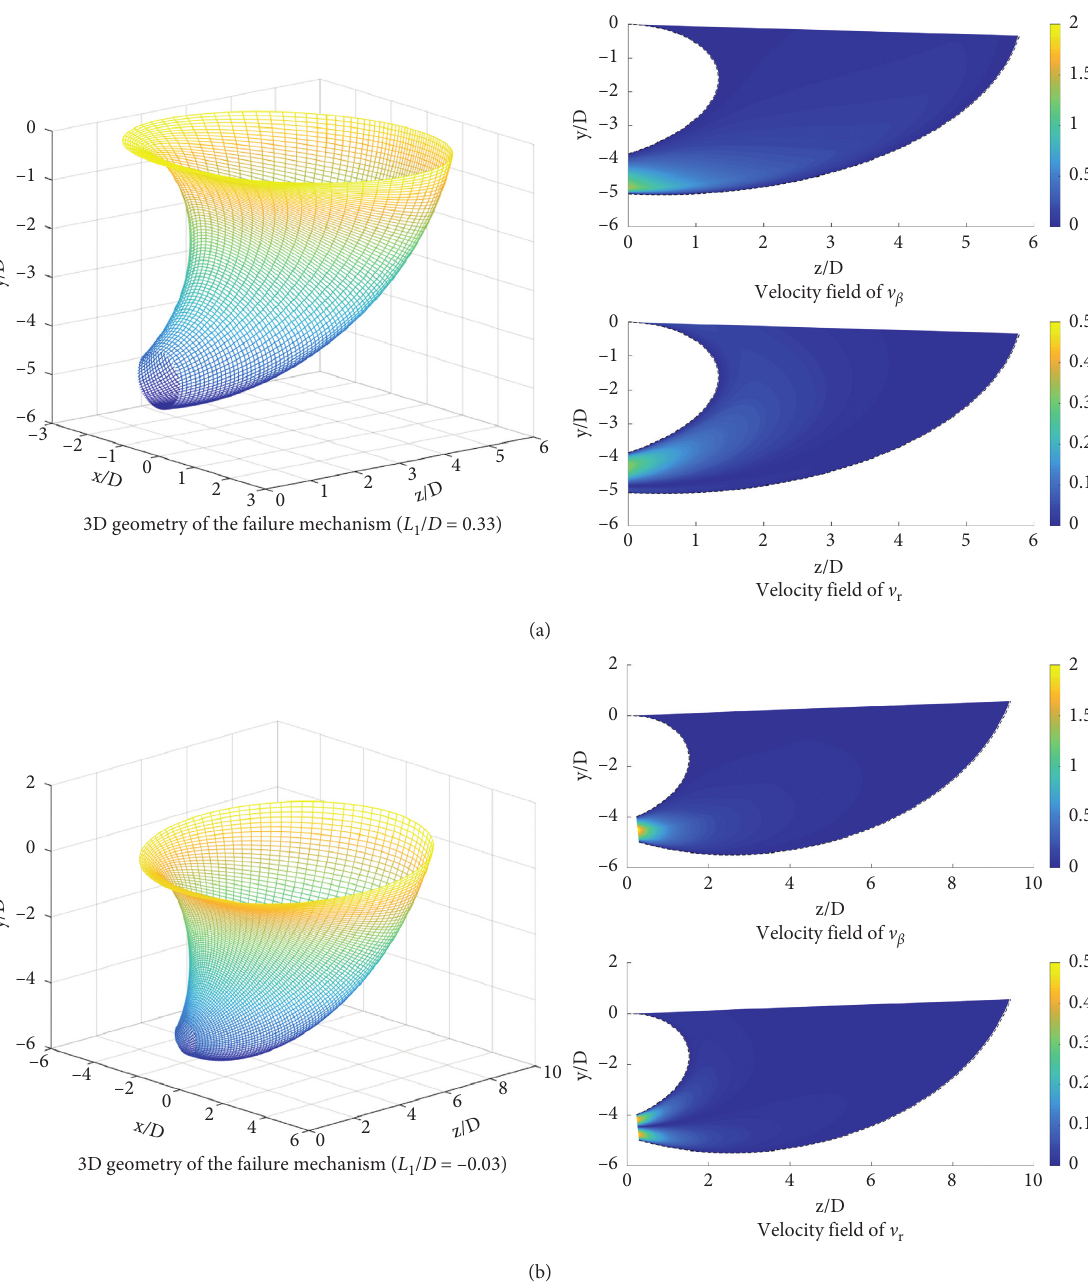
� 10, and η � 6%): (a) tunneling in u